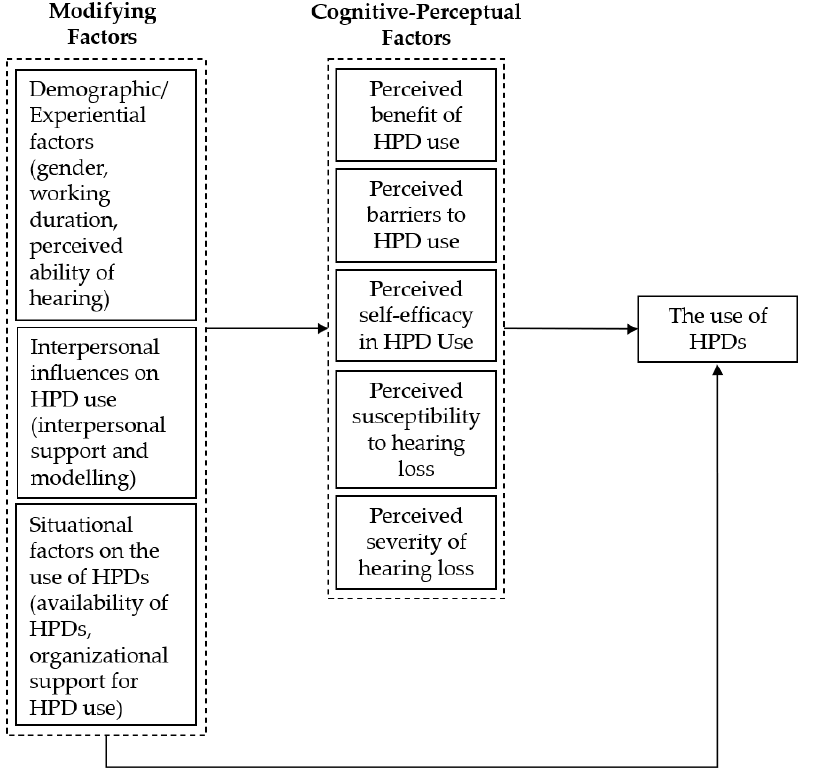
Figure 1. Predictors of Industrial Workers’ Use of Hearing Protection Model (Tantranont and Cod- chanak, 2017).